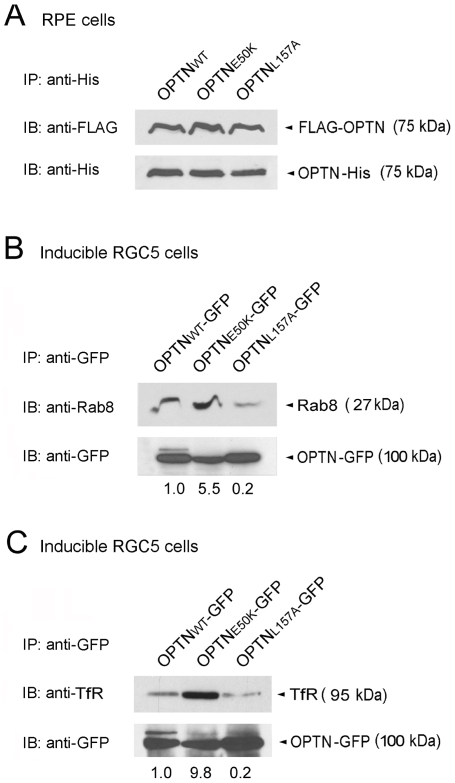
Self binding of optineurin mutants and their interactions with Rab8 and TfR.(A) Self binding of wild type optineurin and mutants. RPE cells were co-transfected with pOPTNWT-His + pTarget-FLAG-OPTNWT, pOPTNE50K-His + pTarget-FLAG-OPTNE50K, or pOPTNL157A-His + pTarget-FLAG-OPTNL157A for 16 h. Cell lysates were immunoprecipitated (IP) with polyclonal anti-His. The IP eluates were immunoblotted (IB) with monoclonal anti-FLAG or monoclonal anti-His. The anticipated molecular weight of the proteins detected by both antibodies was 75 kDa. No protein band was detected when rabbit IgG was used for immunoprecipitation (data not shown). (B) Binding of wild type optineurin and mutants with endogenous Rab8. Inducible RGC5 cells were treated with doxycycline for 16 h to express OPTNWT-GFP, OPTNE50K-GFP and OPTNL157A-GFP. Cell lysates were immunoprecipitated (IP) with polyclonal anti-GFP. The IP eluates were immunoblotted (IB) with monoclonal anti-Rab8 or polyclonal anti-GFP. The intensity ratio between the detected 27-kDa-Rab8 band and the 100 kDa-OPTN-GFP band relative to that of the wild type optineurin is presented. No protein band was observed in lysate samples obtained from non-induced cells (data not shown). (C) Binding of wild type optineurin and mutants with endogenous TfR. Inducible stable cell lines were induced by doxycycline to express OPTNWT-GFP, OPTNE50K-GFP or OPTNL157A-GFP. Cell lysates were immunoprecipitated (IP) with a polyclonal anti-GFP antibody. The IP eluates were immunoblotted (IB) with a monoclonal anti-TfR antibody or anti-GFP. The intensity ratio between the 95-kDa TfR band and the 100 kDa-OPTN-GFP band relative to that of the wild type optineurin is presented. No protein band was observed in lysate samples obtained from non-induced cells (data not shown).